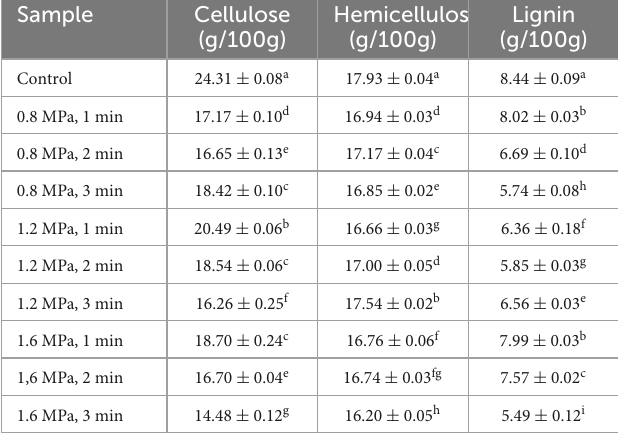
TABLE 1 Effect of steam explosion (SE) pretreatment on chemical compositions of adlay